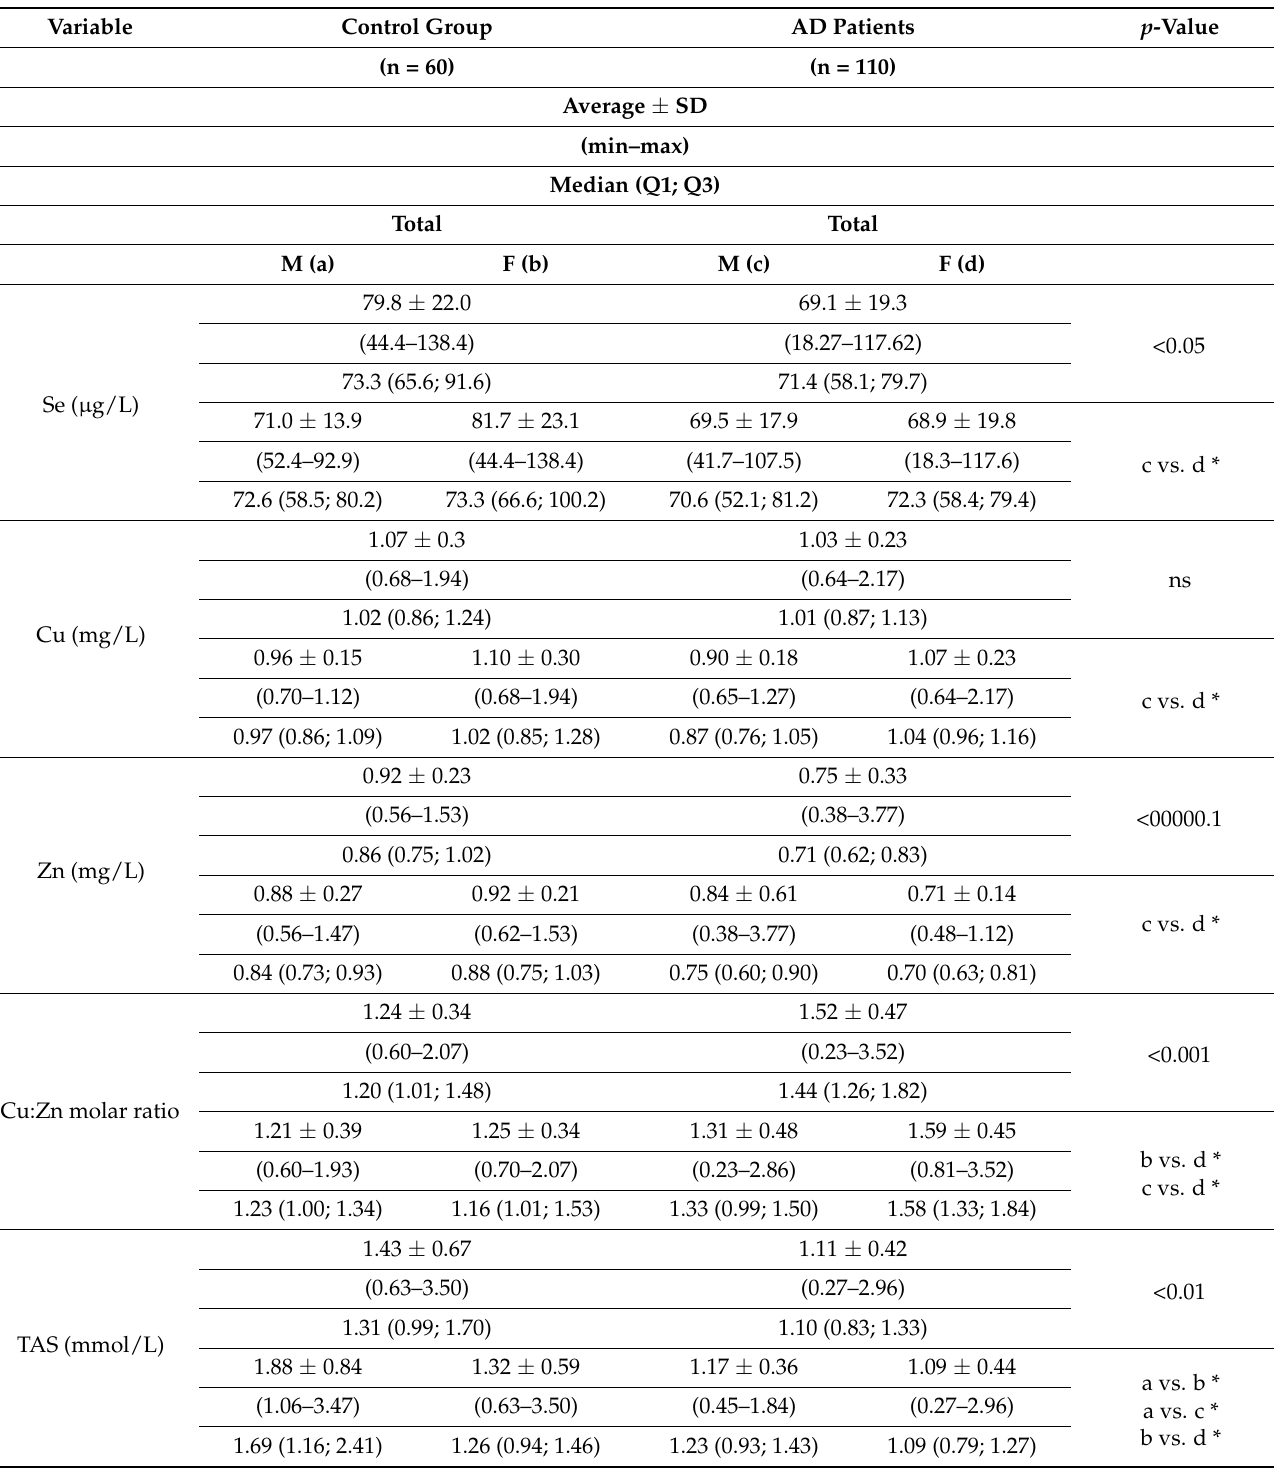
Table 2. The concentration of selenium, copper, zinc, copper:zinc molar ratio, and total antioxidant status in the serum of patients with Alzheimer’s